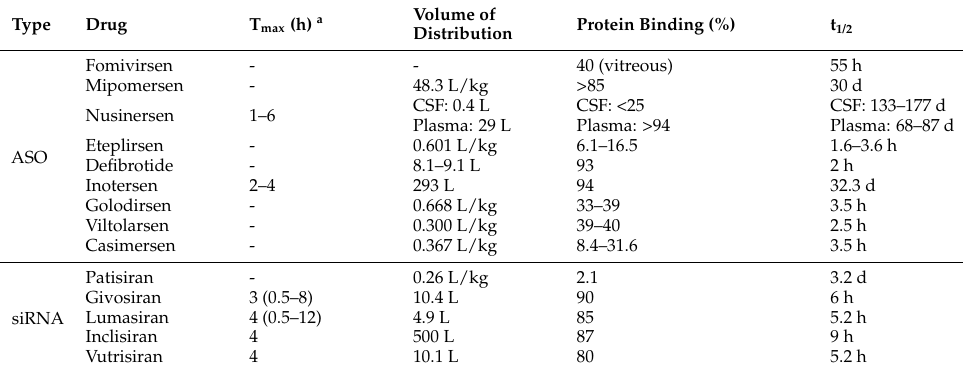
Table 2. Pharmacokinetic parameters of the RNA